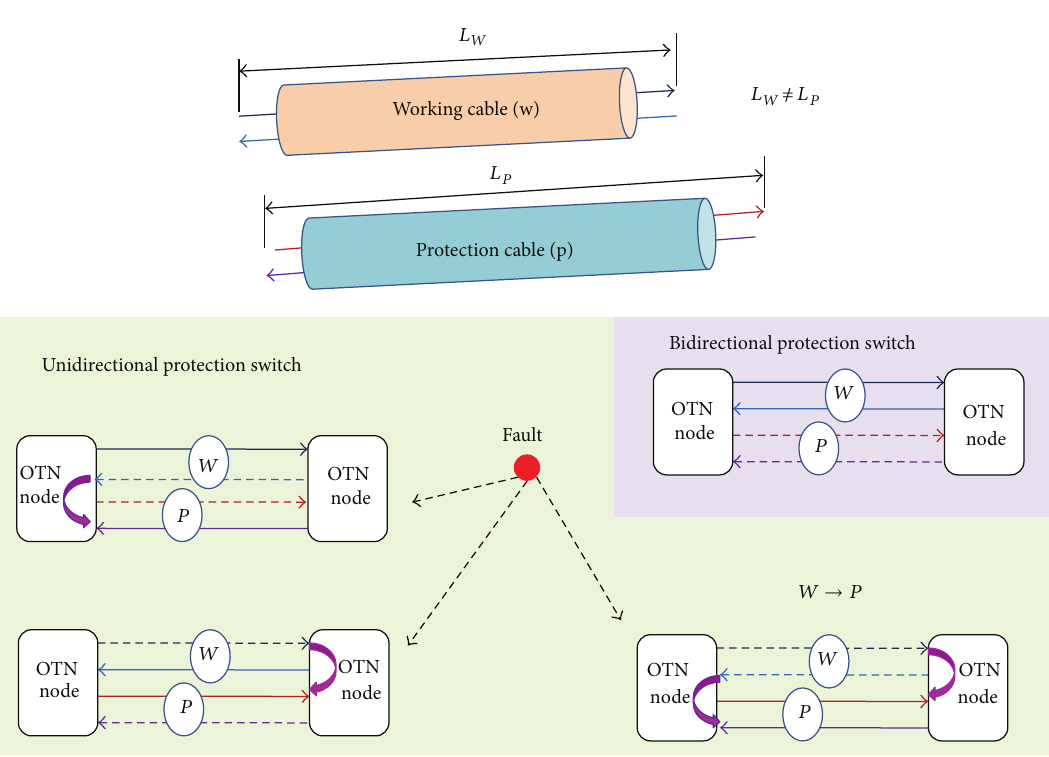
Figure 6: Schematic illustration of bidirectional/unidirectional network protection switches.